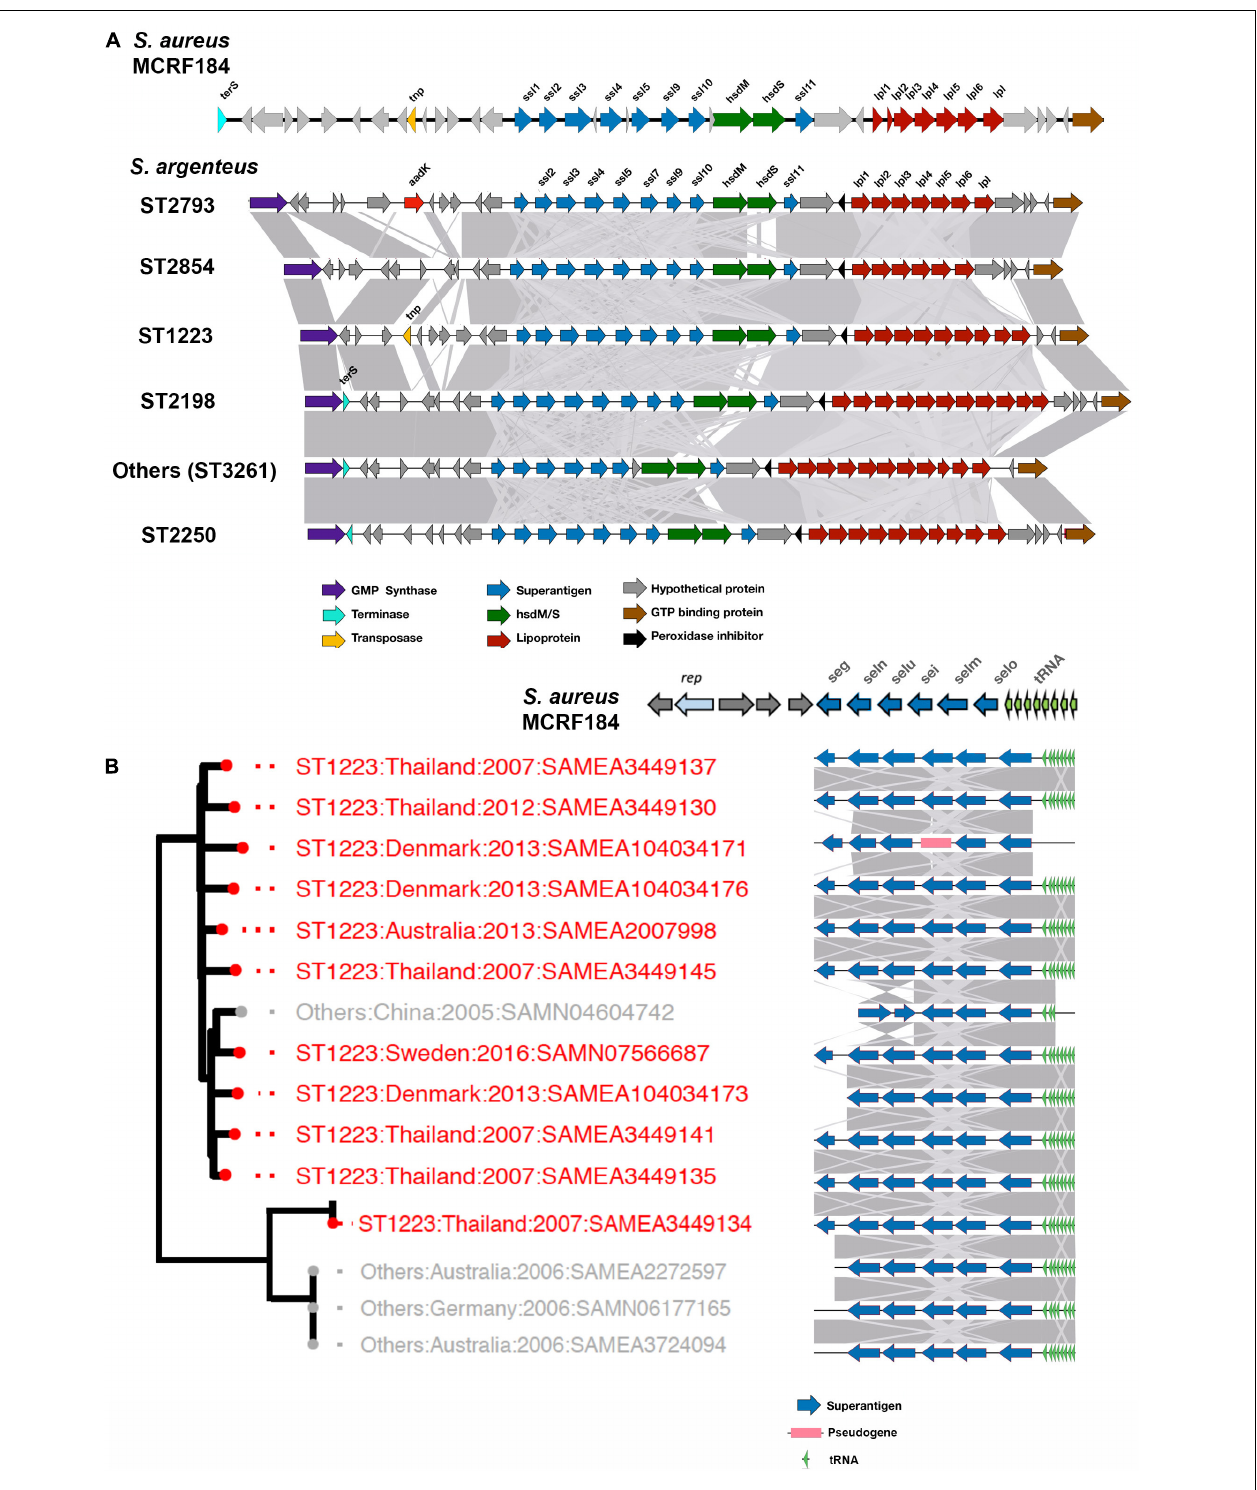
FIGURE 4 | vSA α and vSA β elements in S. argenteus. The figure shows the gene composition of vSA α (A) and vSA β (B) elements in the strains of S. argenteus indicated. In panel (A) , a representative member from each ST is shown. Gene functions are color coded as indicated. The degree of similarity between the different S. argenteus strains is shown by the gray shading. In both panels, the arrangement of genes in the cognate elements of the MCRF184 strain of S. aureus is shown. rep is a bacterial replicase (helicase).